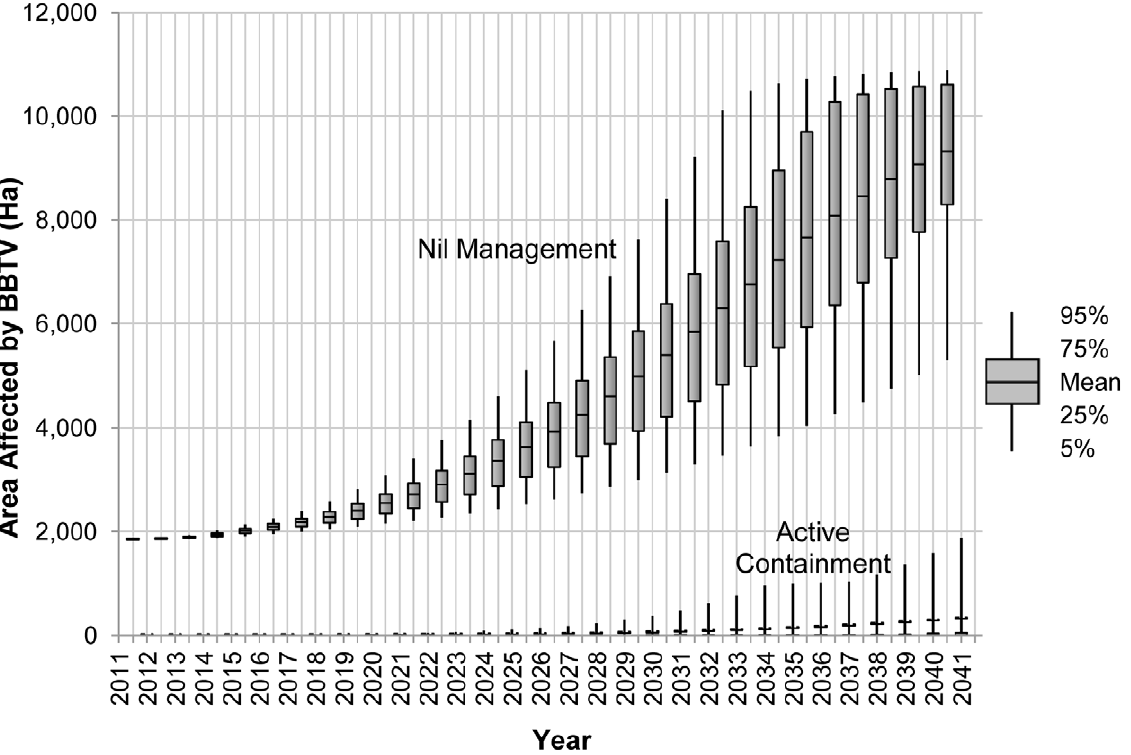
Figure 1. Likely spread of BBTV over time with and without an active containment policy.